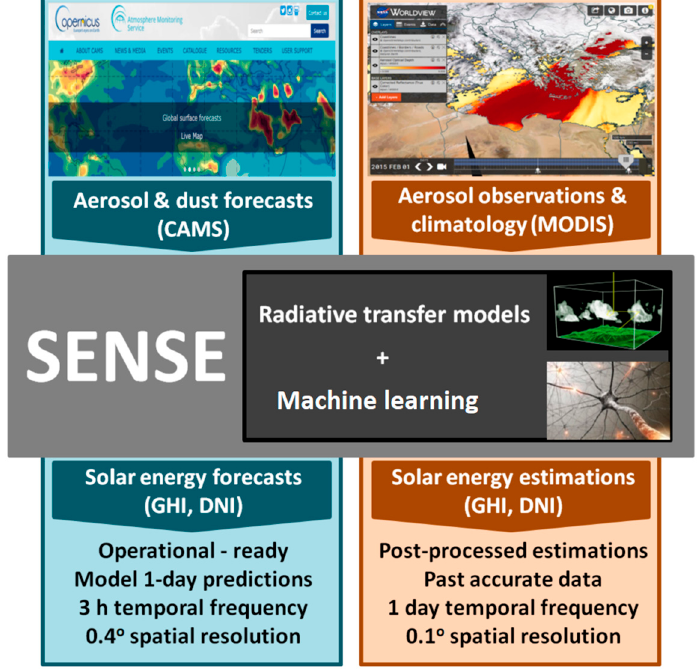
Figure 2. Flowchart of the SENSE scheme. The initial data sources followed by the observational or forecasted aerosol inputs to the SENSE and the analogue solar energy related outputs.